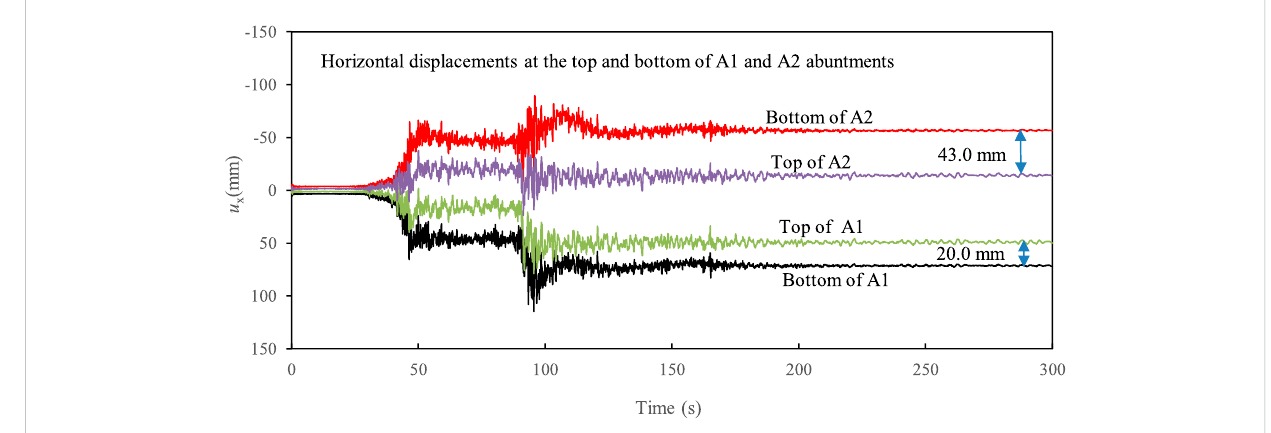
FIGURE 4 Time history of horizontal displacements at the top and bottom of two abutments, i.e., A1 and A2 (Case 1).